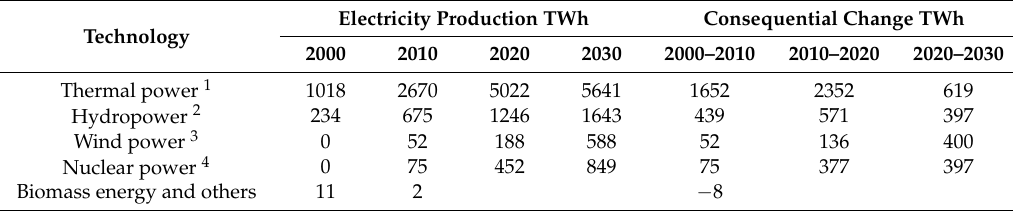
Table 1. Electricity production in China in 2000, 2010, 2020, and